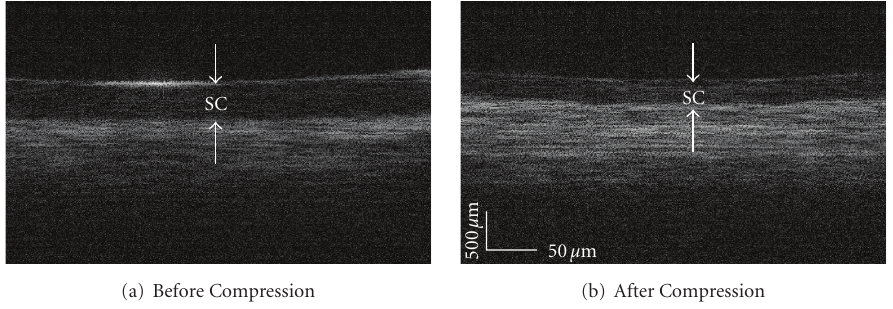
Figure 5: Representative OCT images and analysis of a human fingertip (a) before and (b) after compression. White arrows denote the stratum corneum.